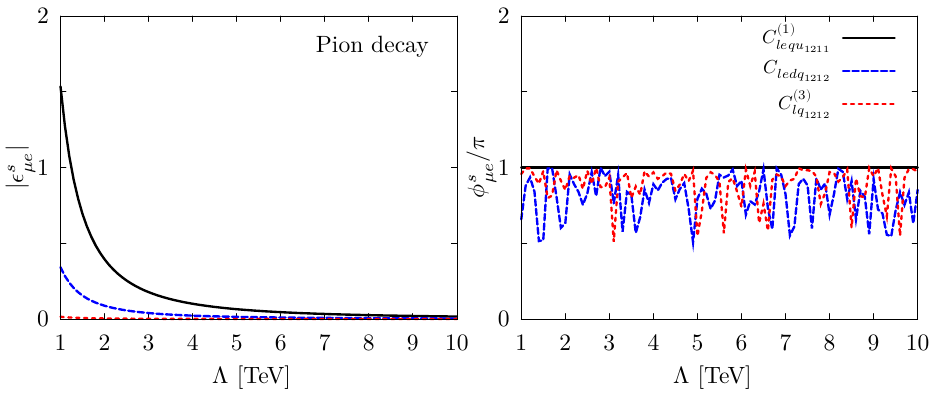
Figure 13 . The magnitude and phase of the source NSI parameter (cid:15) s oscillation experiments. The values obtained for the NSI parameter are shown for one CP -conserving operator (solid black) and two CP -violating operators (dashed blue and dotted red) as function of the scale Λ .